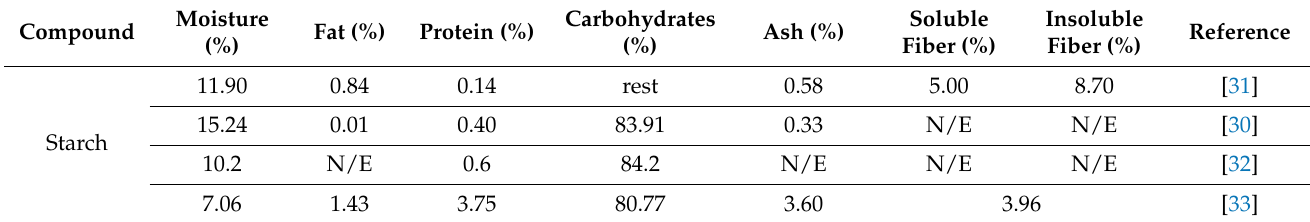
Table 1. Arrowroot rhizome starch composition. N/E—not evaluated. Compound